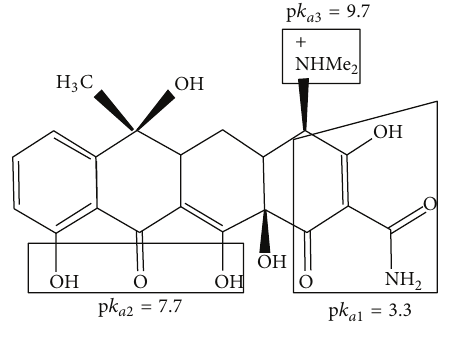
Figure 1: Molecular model of TC.